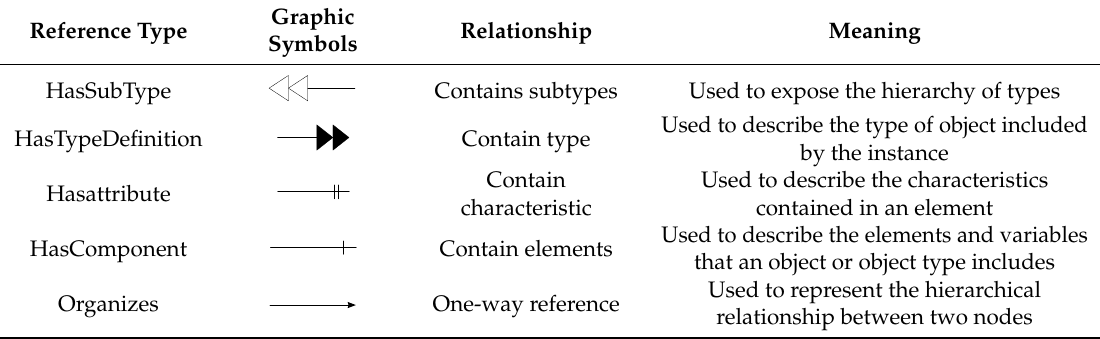
Table 6. Reference type relationships between elements.